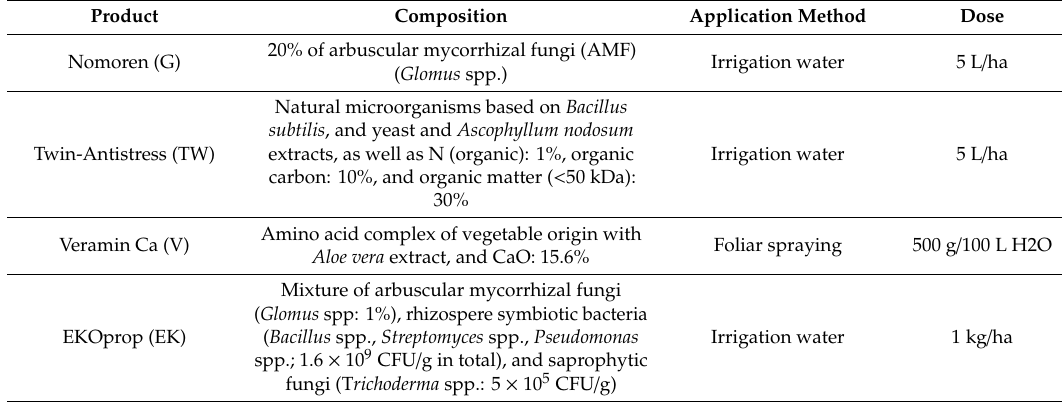
Table 1. Detailed composition and application guides for the tested biostimulants.